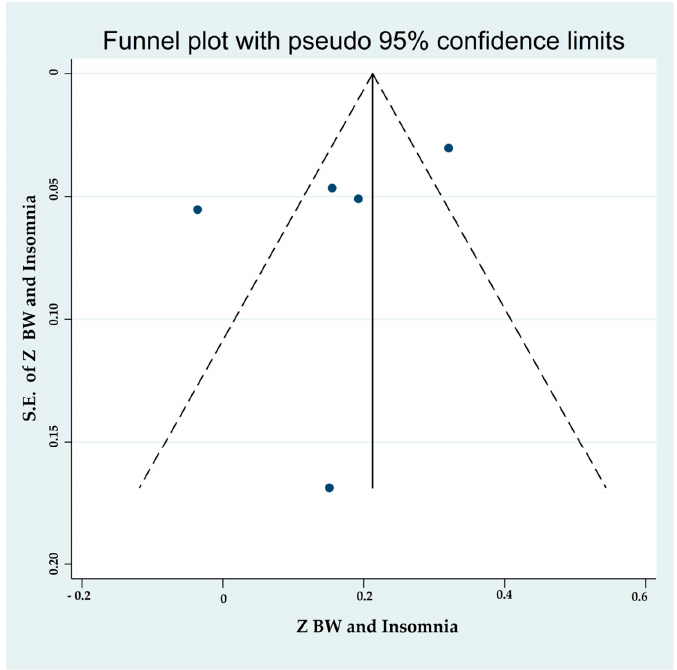
Figure 16. The funnel plot displaying the estimated pooled Fisher’s z-score in the association between binge-watching and insomnia.